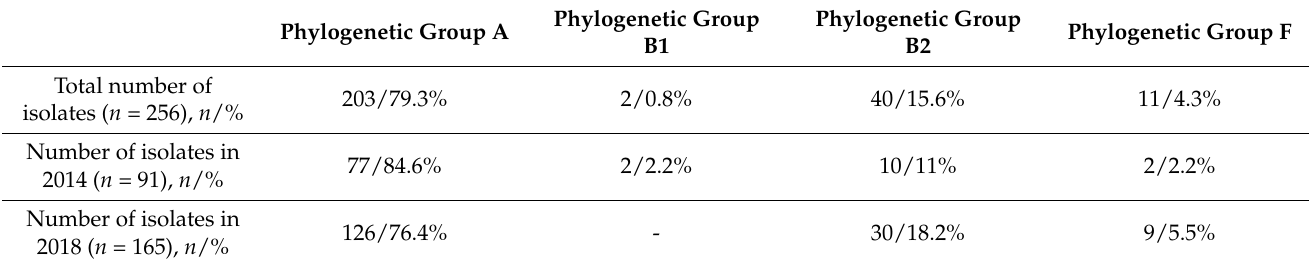
Table 4. Phylogenetic groups detected in 2014 and